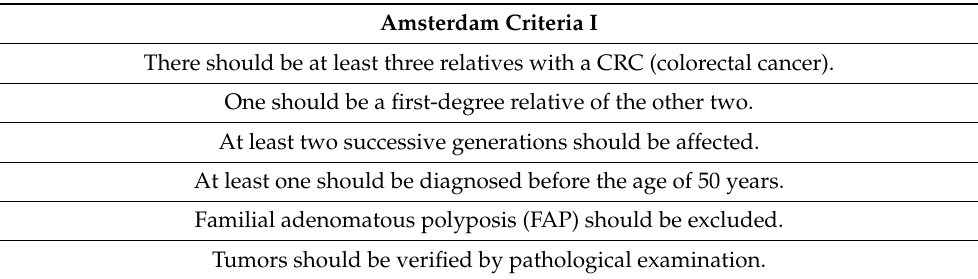
Table 1. Amsterdam criteria I for LS patient identification [34].